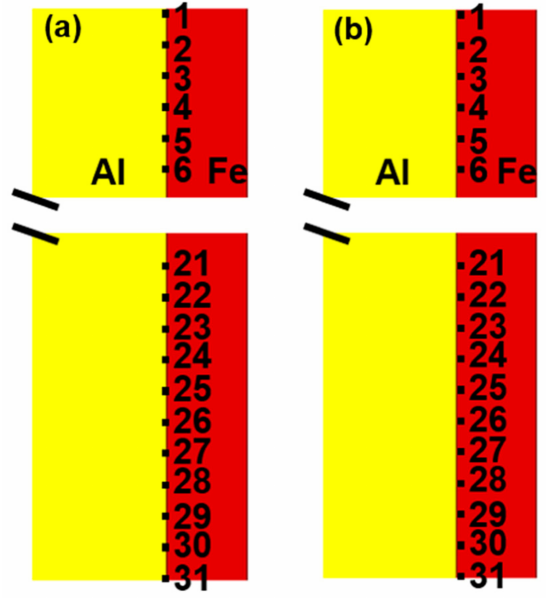
Figure 16. Tracking points: ( a ) the aluminum interface, ( b ) the steel interface.